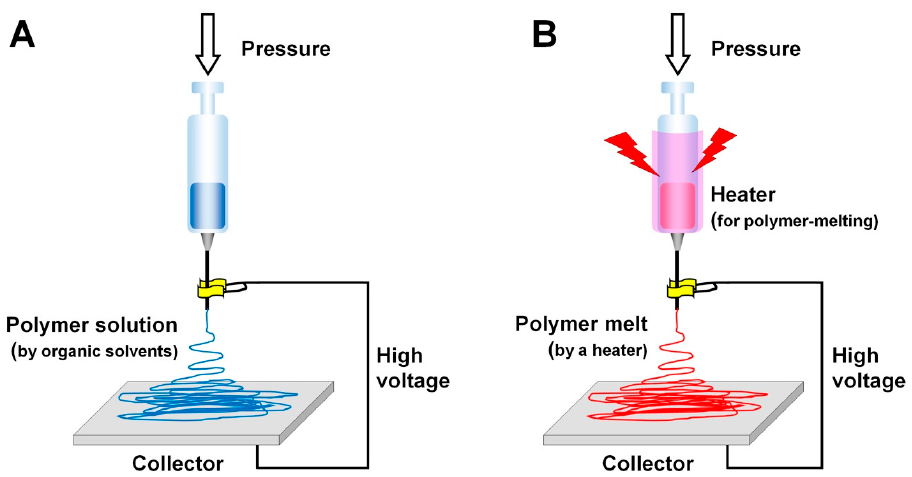
Figure 3. The schematic illustration of electrospinning types: solution electrospinning ( A ) and melt electrospinning ( B ).